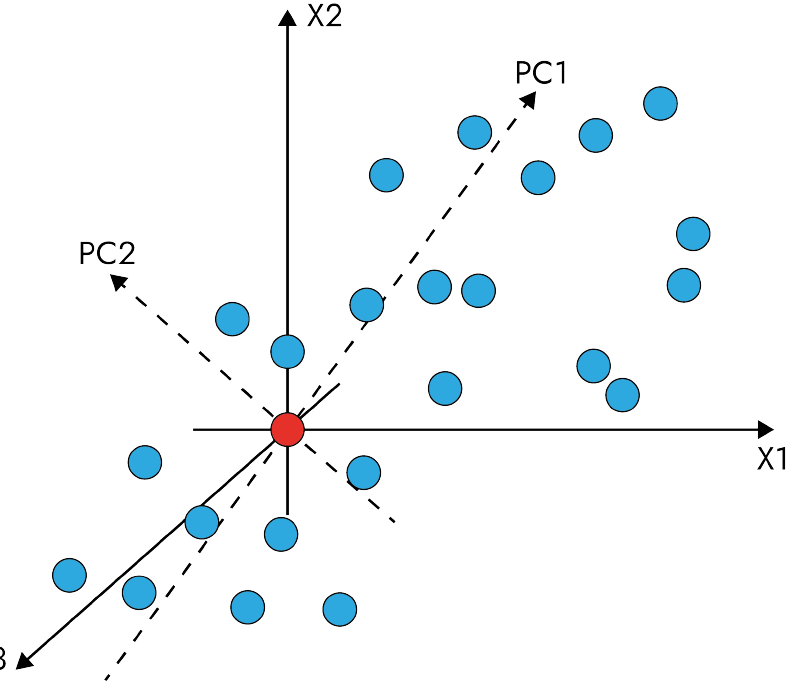
Figure 5. Principal component analysis